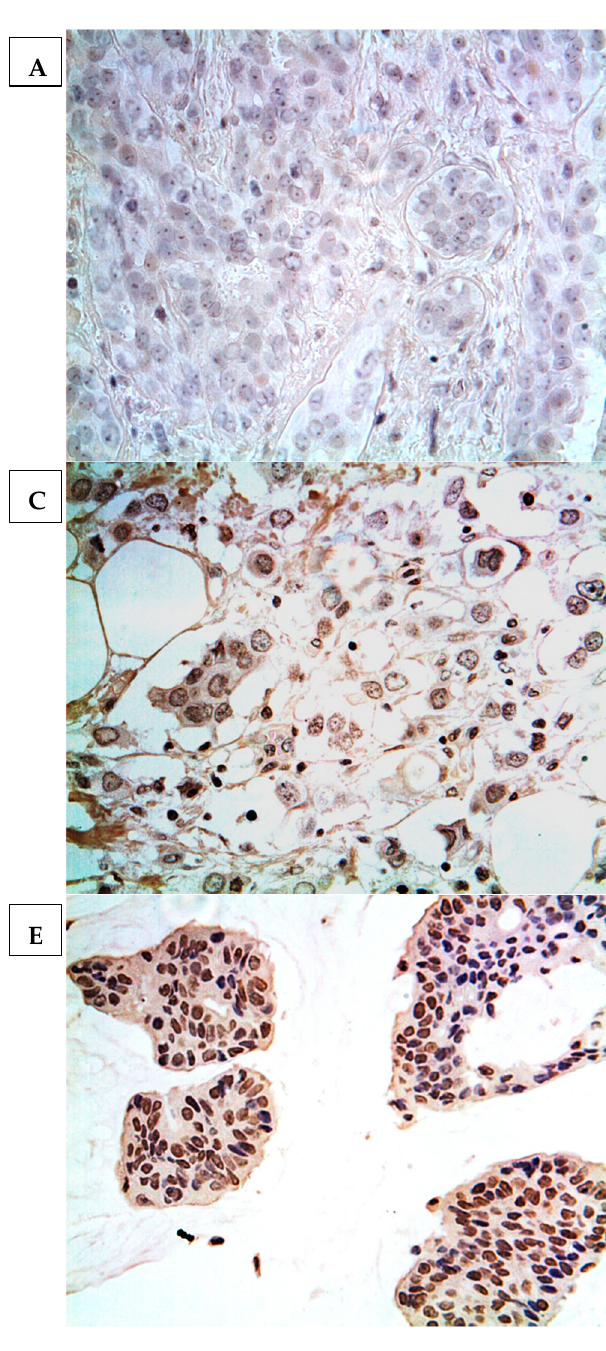
Figure 1. GPC3 expression in different histological subtypes of breast cancer. Classification was performed according to histopathological subtype. ( A ): normal breast tissue, ( B ): invasive ductal car- cinoma, ( C ): invasive lobular carcinoma, ( D ): intraductal carcinoma, ( E ): mucinous adenocarcinoma, ( F ): Paget’s disease. Magnification ×